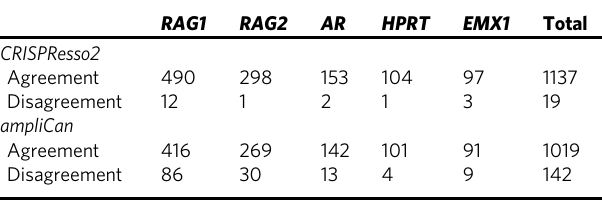
Table 1 Active site classi fi cation results comparison between CRISPECTOR to CRISPResso2 and